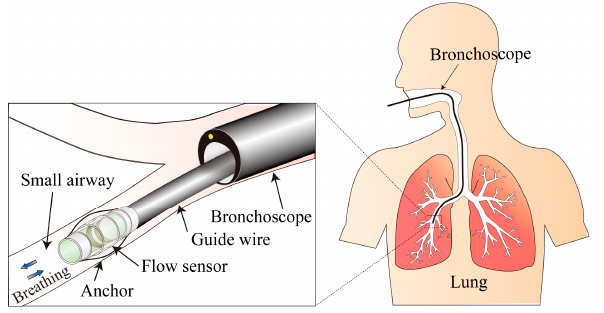
Figure 1. Breathing measurements by catheter flow sensor at tracheobronchial airway.